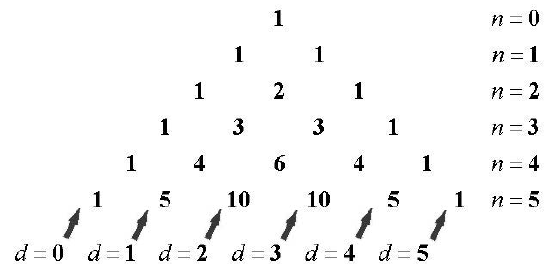
Figure 12: The first six rows of Pascal’s triangle, from row 0 to row